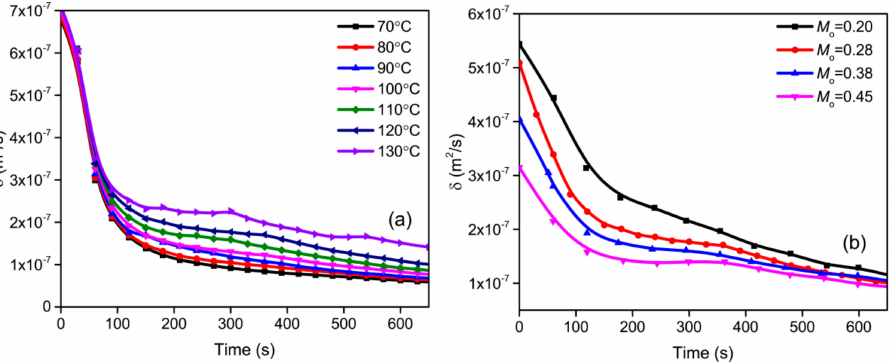
Figure 7. Evolutions of the distribution of effective diffusivity ( δ ) with drying time for: ( a ) drying temperature; ( b ) initial moisture